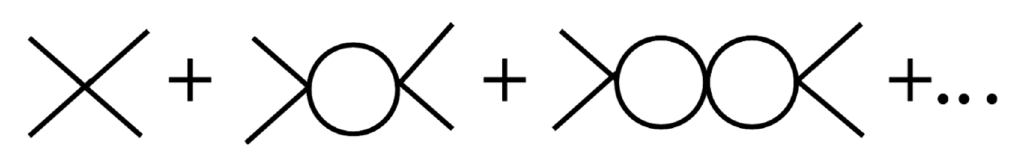
Figure 11 . Examples of alternating integer and half-integer bubble Witten diagrams. Using Identities 5,6, and 7. We are suppressing numerical coe(cid:14)cients in these plots.